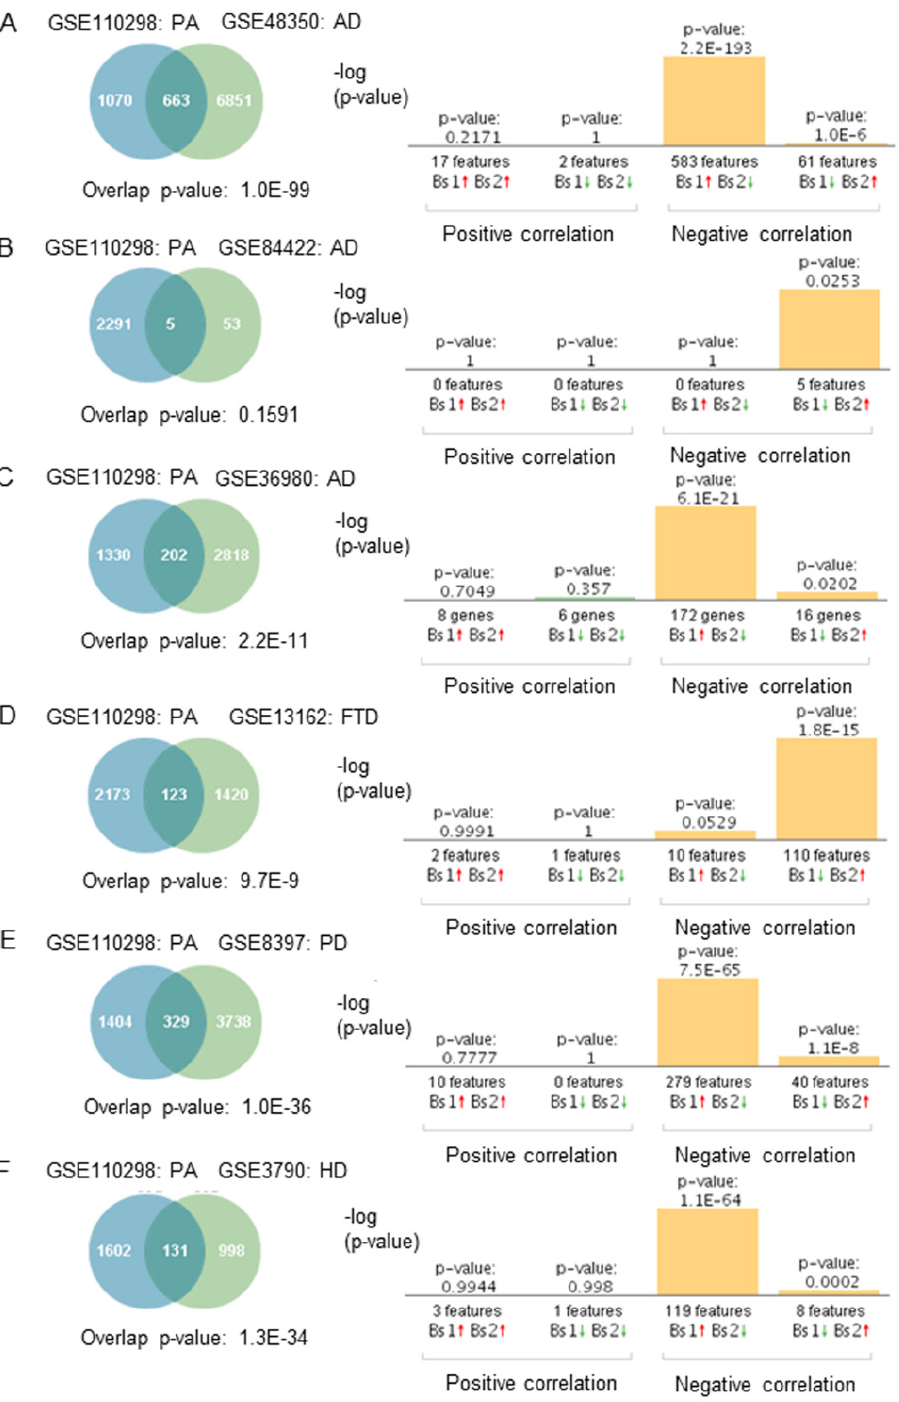
engaged in low physical activity. We compared gene expression profiles from subjects who engaged in low physical activity to those affected by neurodegenerative diseases to